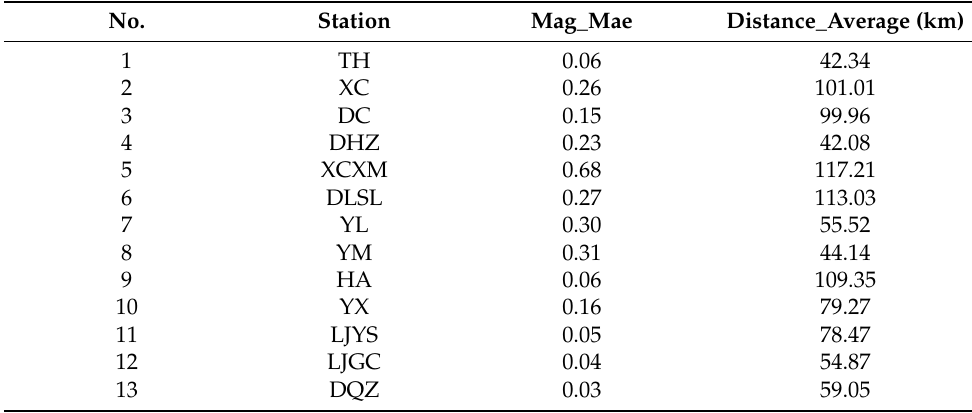
Table A7. Prediction results of LSTM model for magnitude and epicenter on